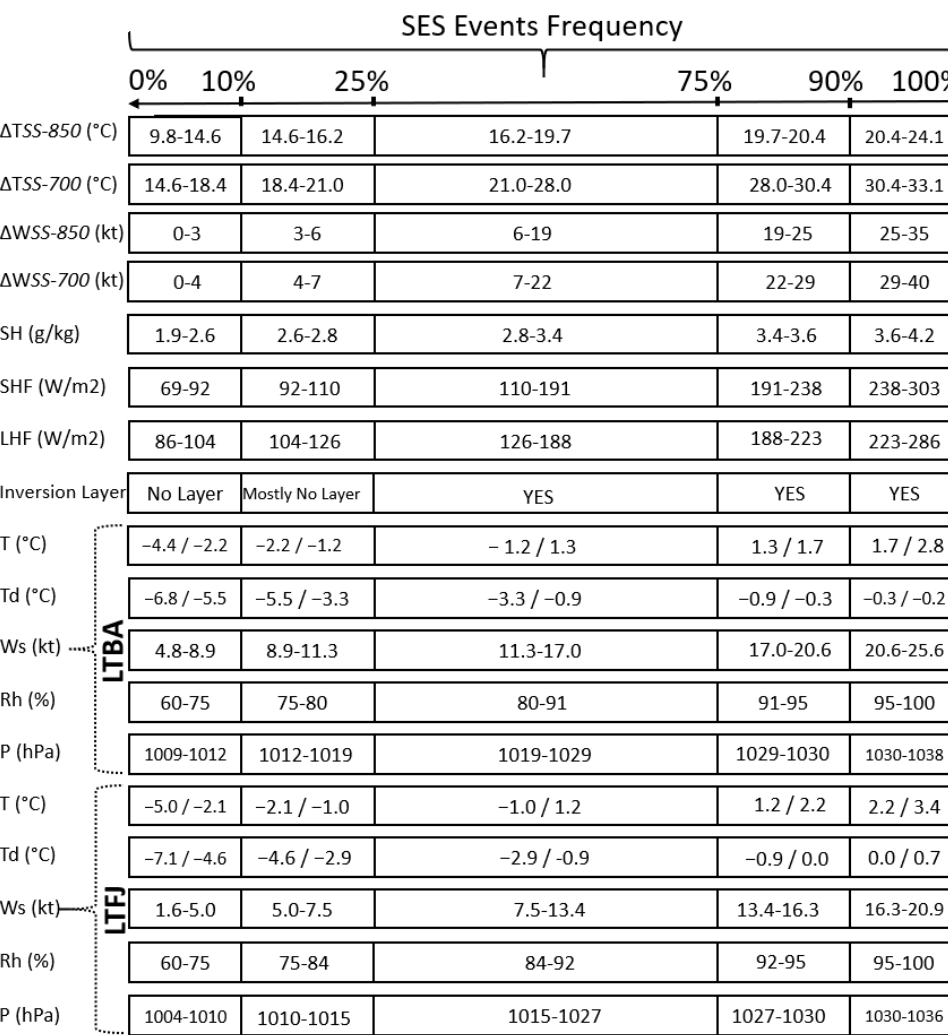
Figure 8. Changes in average meteorological parameter values in SES events at LTBA and